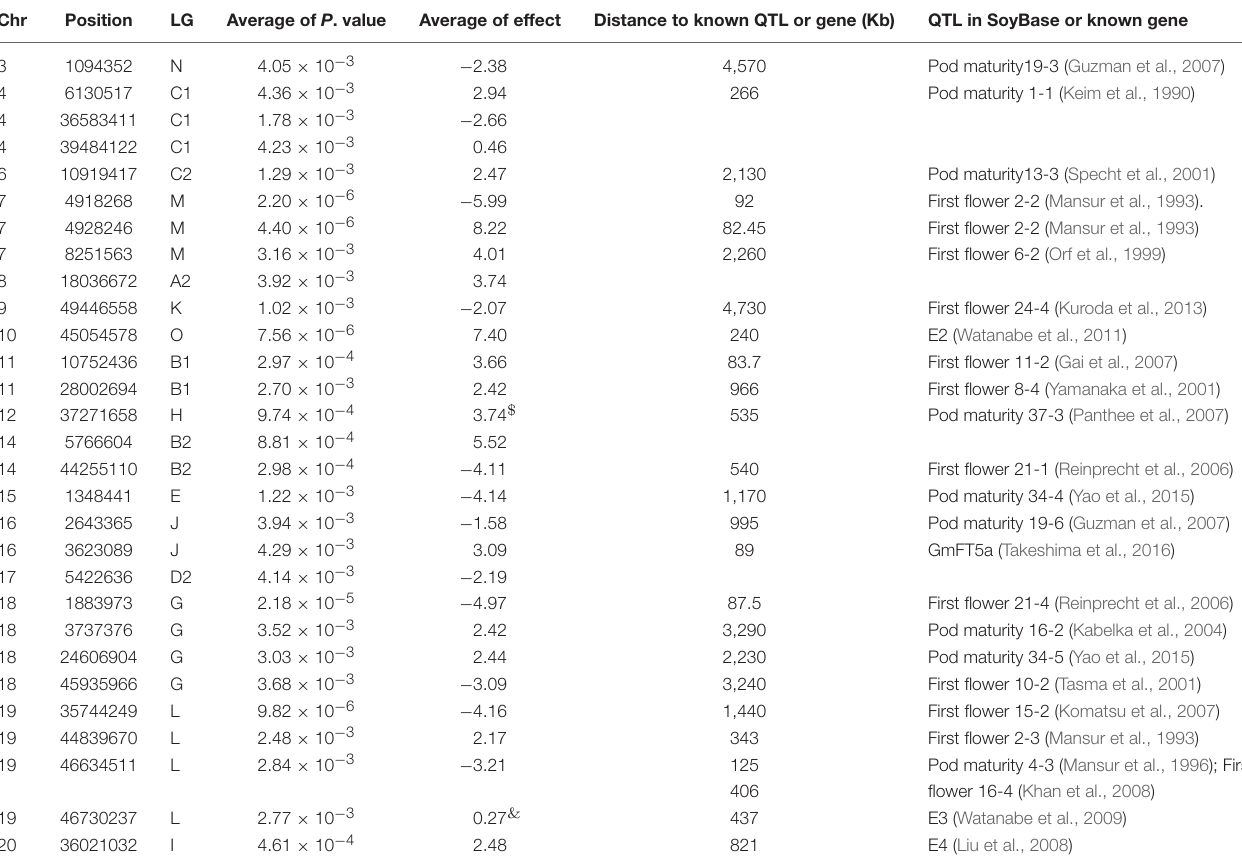
TABLE 4 | Physical position, P -value, effect, and distance to known QTL or known genes of QTN for flowering time (R1) and maturity (R7 and R8) detected using FarmCPU. Chr Position LG Average of P .